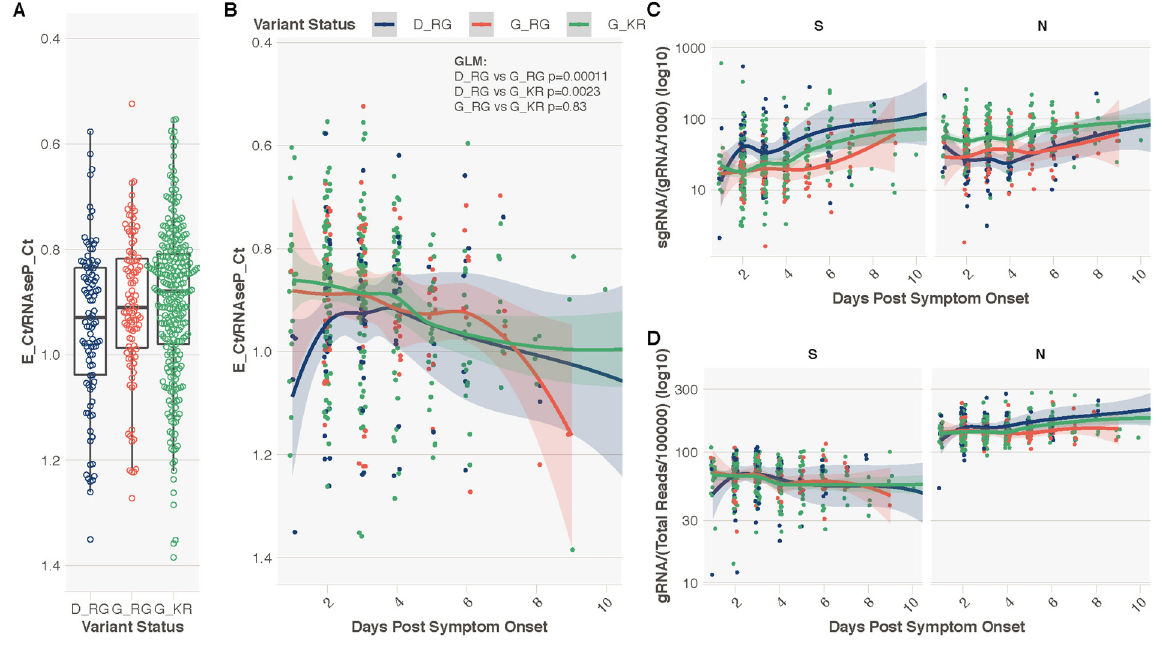
Figure 5. Spike 614 and Nucleocapsid 203/204 Status, Diagnostic Metrics, and level of sub-genomic and genomic RNA. A. E gene cycle threshold (CT) normalized to RNase P CT stratified by variant status in N = 478 individuals from Sheffield dataset with day of symptom onset data available. This normalization was done to combine and display E gene CT data from 2 different extraction protocols. Y-axis reversed to aid interpretation, as lower normalized CT values equal higher virus levels. B. Normalized E gene CT vs the day of sampling from day of symptom onset. P values provided are from a generalized multivariable linear regression model (GLM) for the difference in normalized E gene CT value between samples containing each variant, with extraction method and day of illness included in the model (Table S6). C. Normalized (per 1000 genomic reads) sgRNA levels for ORFs S and N. D. Normalized (per 100,000 mapped reads) genomic RNA levels for ORFs S and